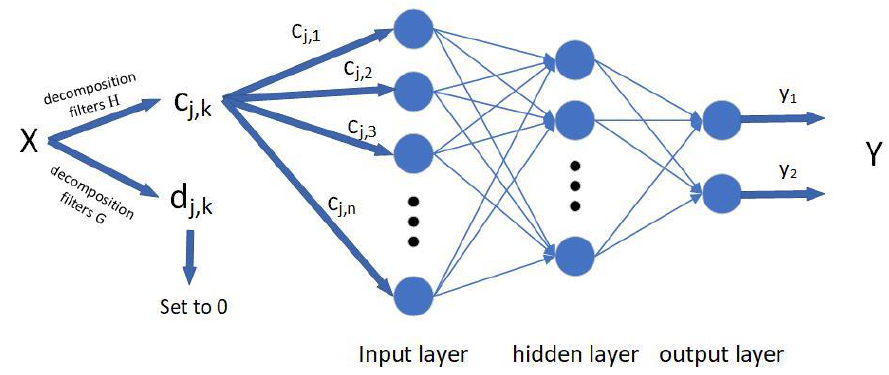
Figure 1. Principles of neural networks.